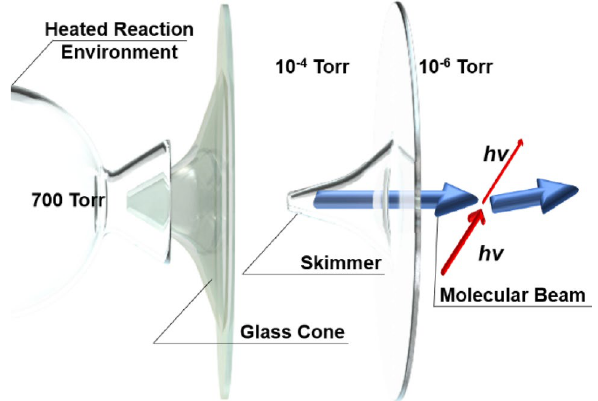
Figure 2. Configuration of the jet stirred reactor (JSR) and the mass spectrometer expansion stages for use with the Synchrotron beam (hν).